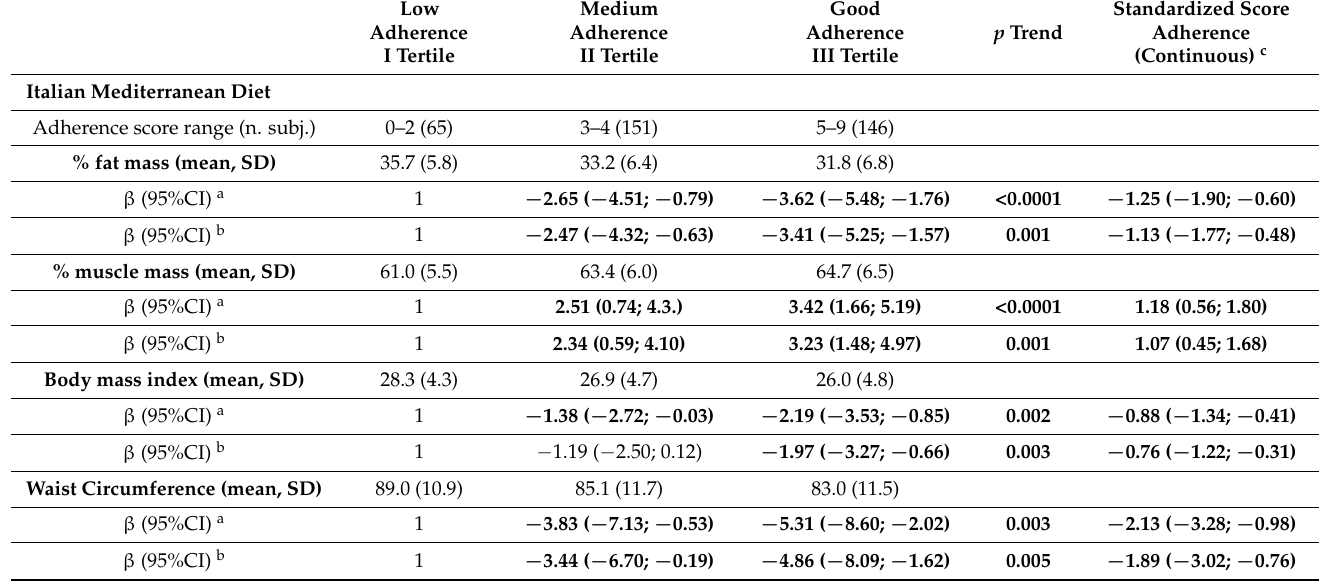
Table 2. Association between the adherence to the three a priori dietary patterns and percentage fat mass, percentage muscle mass, body mass index, and waist circumference in the 362 EPIC-Florence participants, with follow-up dietary